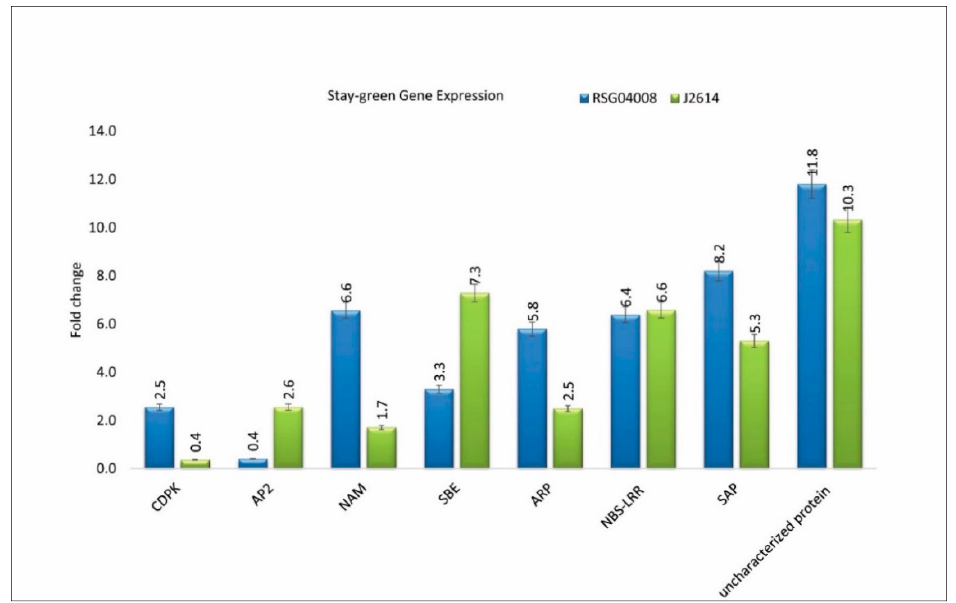
Figure 7. Relative changes of candidate gene expression in parents showing variant expression levels.